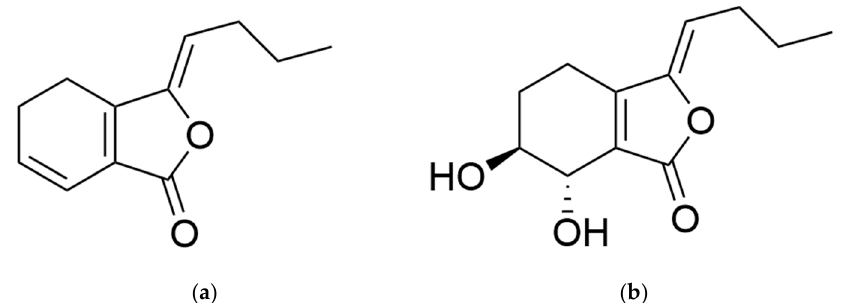
Figure 1. Chemical structure of ( a ) ligustilide and ( b ) senkyunolide I.